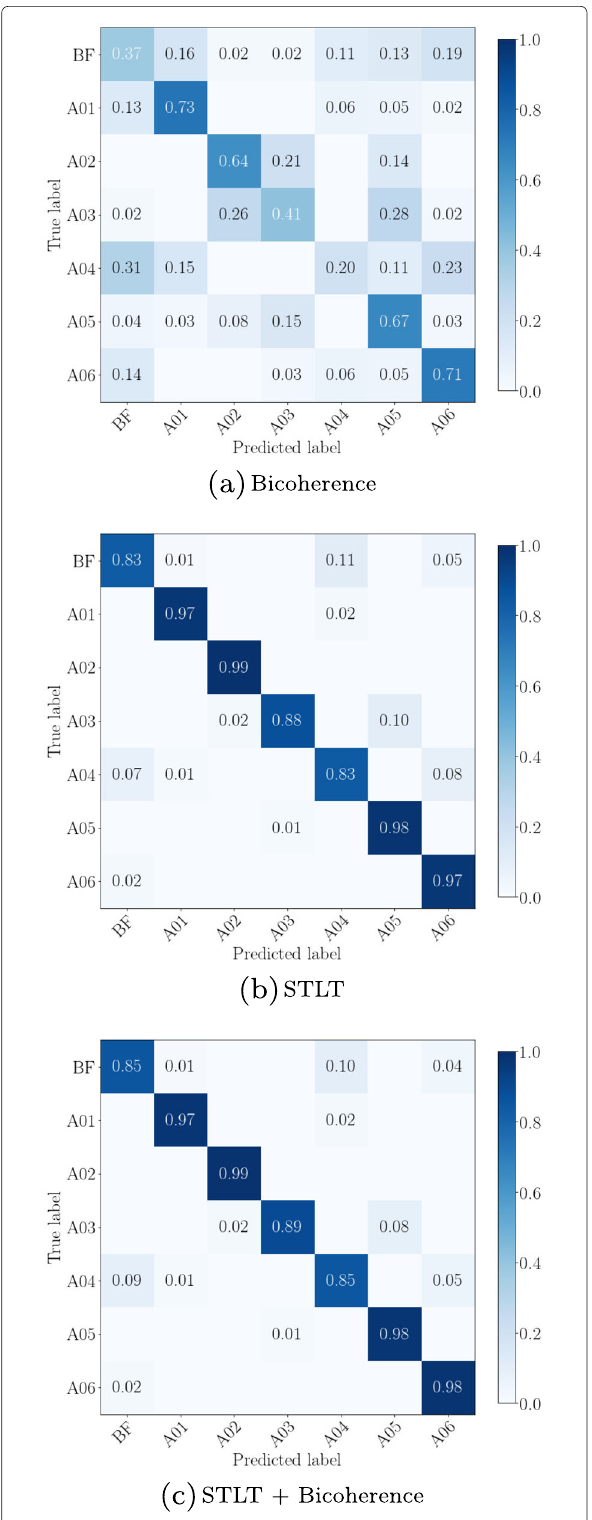
Fig. 4 Confusion matrices showing closed-set results for each used feature vector on dataset D